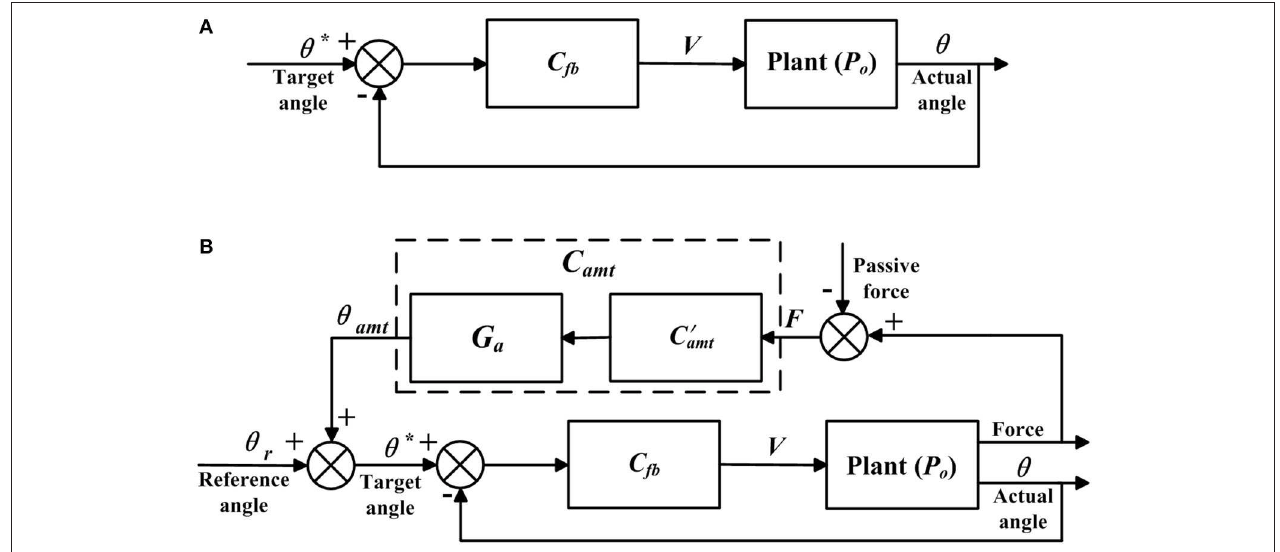
FIGURE 4 | Control algorithms. Adapted from our previous paper (Mu et al., 2019) with permission (license:4797130595869) from IEEE. (A) Closed-loop position control and (B) adjustable admittance